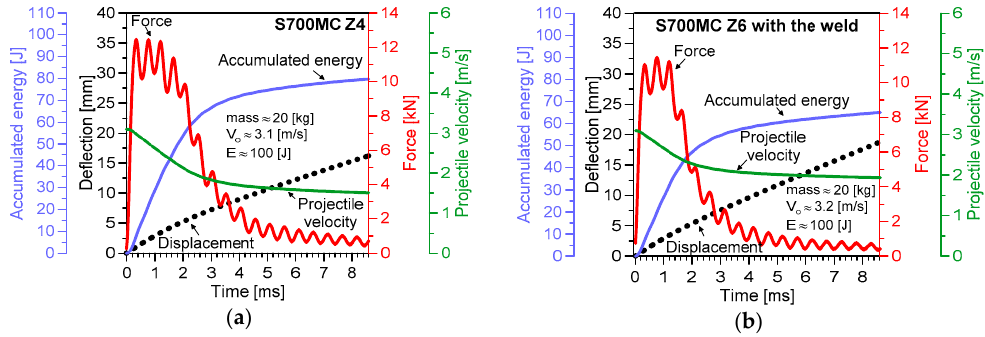
Figure 7. Variations of the Charpy test parameters for the S700MC steel: ( a ) parent material; ( b ) weld; (impact energy: 100 J).